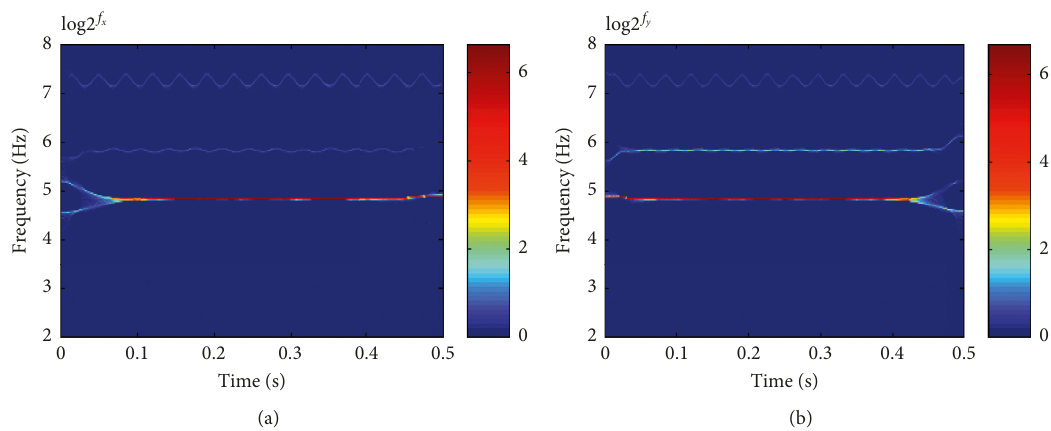
Figure 22: The results of the composite fault signal z based on SWT: the time-frequency representation of (a) the real part of z and (b) the imaginary part of z .